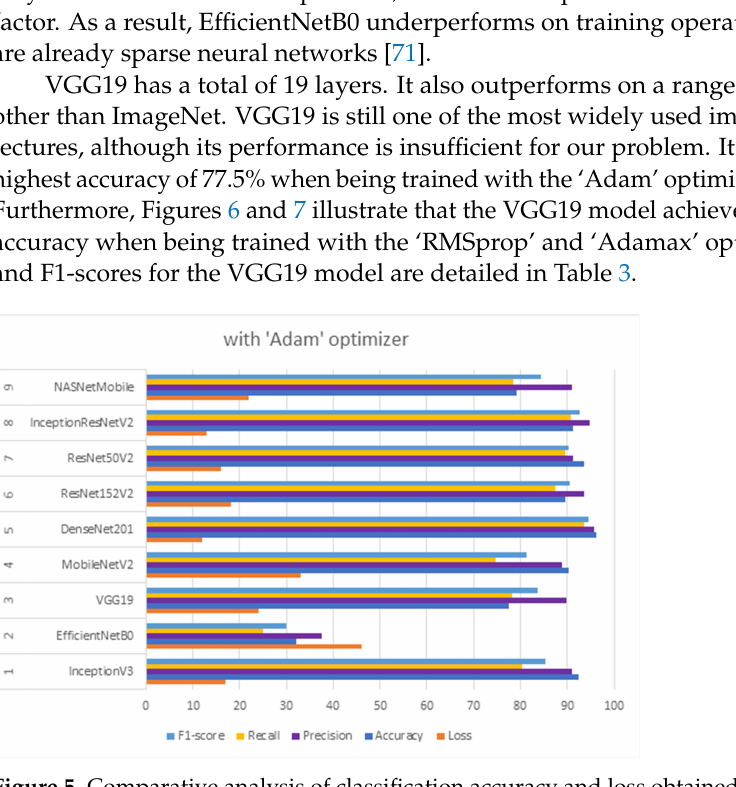
Figure 5. Comparative analysis of classification accuracy and loss obtained using transfer-learning techniques with Adam optimizer.